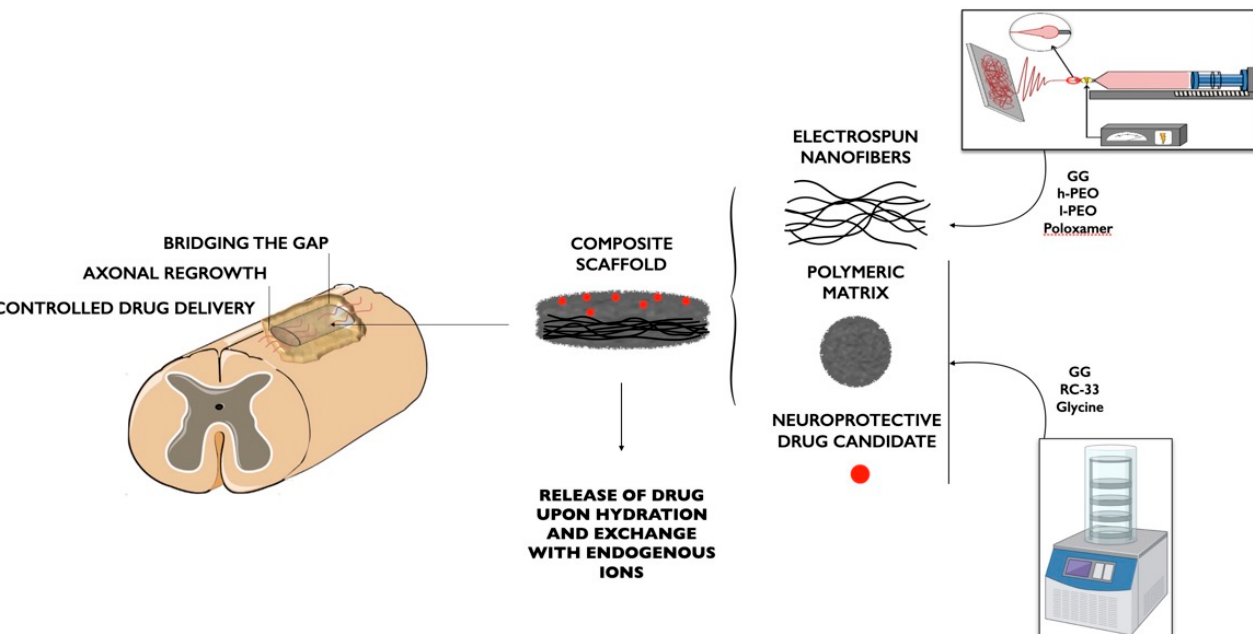
Figure 6. Illustration of the composite scaffold composed of GG electrospun fibers embedded within a GG porous matrix containing RC-33 drug candidate [87].